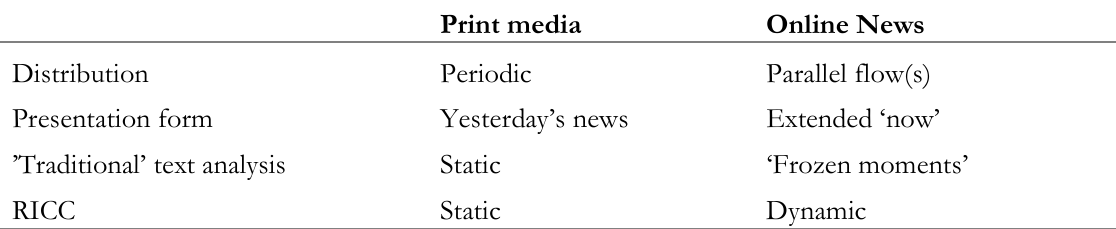
Table 1. Media characteristics and methodological